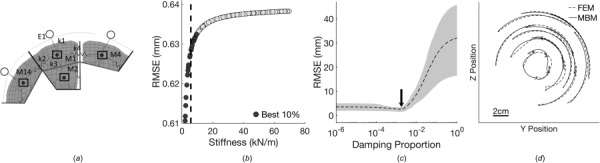
Overview of optimization process for MBMs: (a) planar MBMs were split into subdomains for spring stiffness optimization and (b) a range of spring stiffnesses for each subdomain was tested. The mean stiffness of the 10% of cases (dashed line) with the minimum RMSE was implemented for the subdomain. Springs existing in multiple subdomains were assigned the mean stiffness from subdomain optimization. (c) Planar MBMs were tested for an optimal range of proportional damping values for all springs, with 0.15% damping (arrow) used for all springs in all planes. Shading represents 25th to 75th percentiles. (d) Representative plot comparing nodal position histories of the MBM and FEM in the coronal plane.